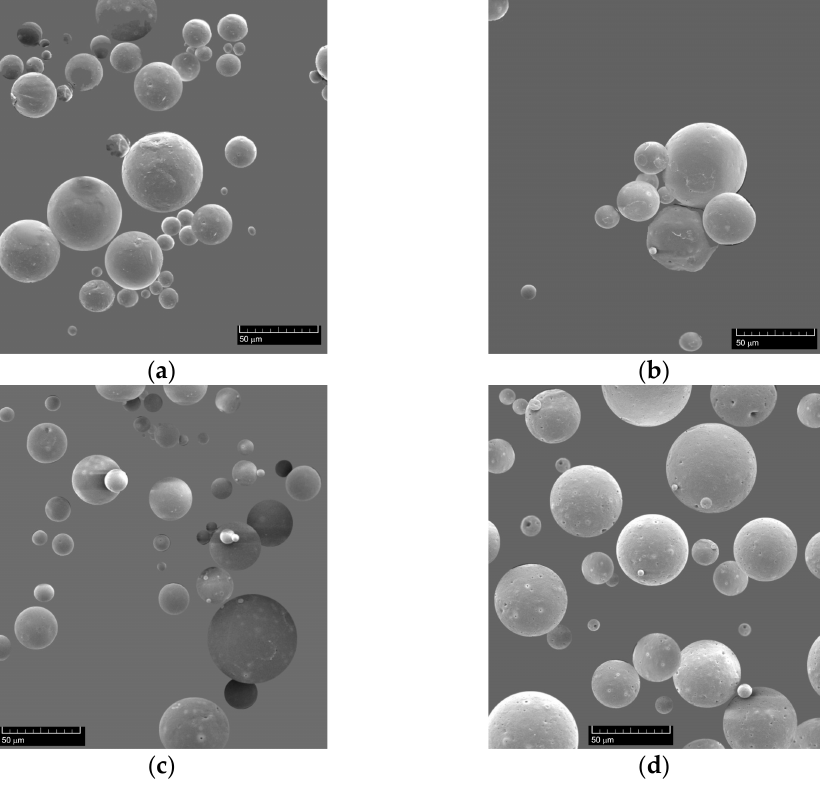
Figure 1. SEM images of ethyl cellulose microcapsules with three different oil masses and empty microcapsules, ( a ) A (m1 = 0.15 g), ( b ) B (m2 = 0.20 g), ( c ) C (m3 = 0.30 g), and ( d ) 0 (microcapsules without oil), magnification 1000x.